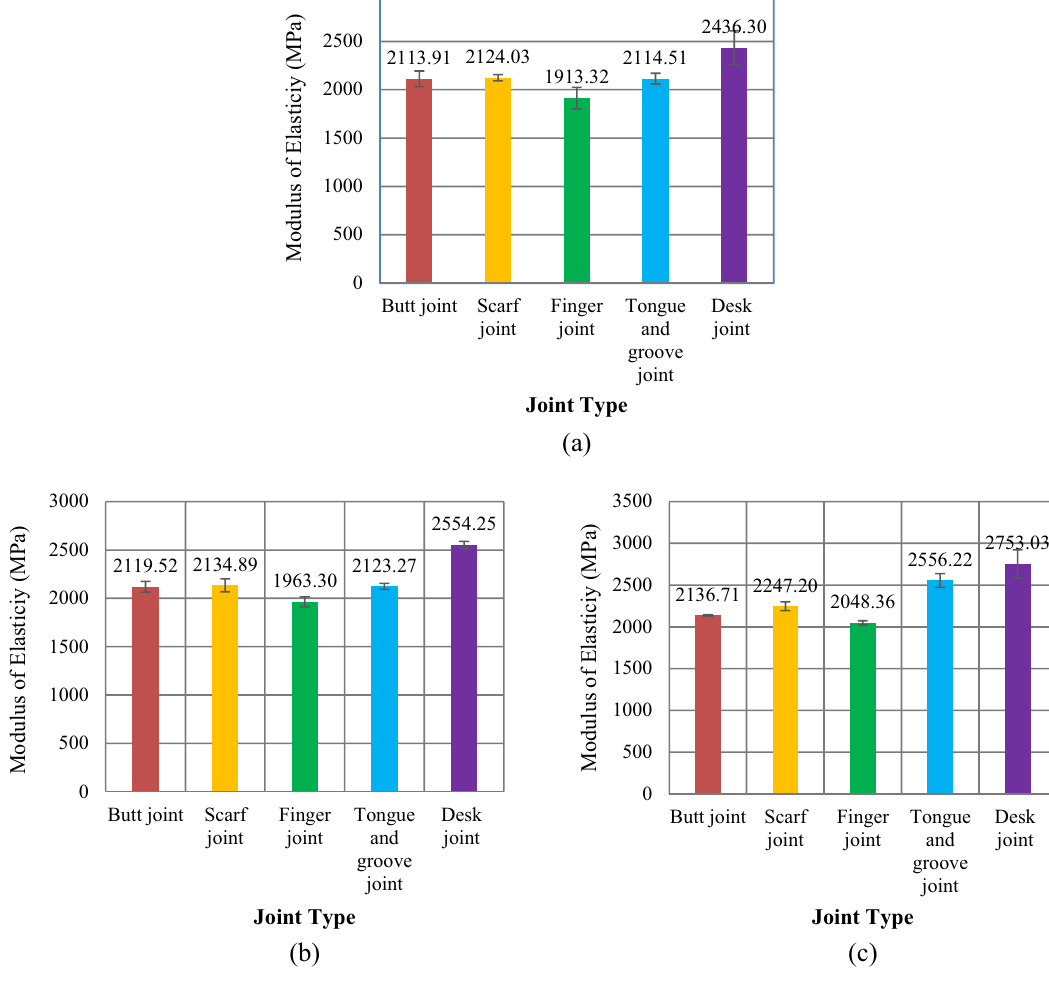
Figure 10: Comparison of the modulus of elasticity of di ff erent joint types for ( a ) 3 layers, ( b ) 5 layers, and ( c ) 7